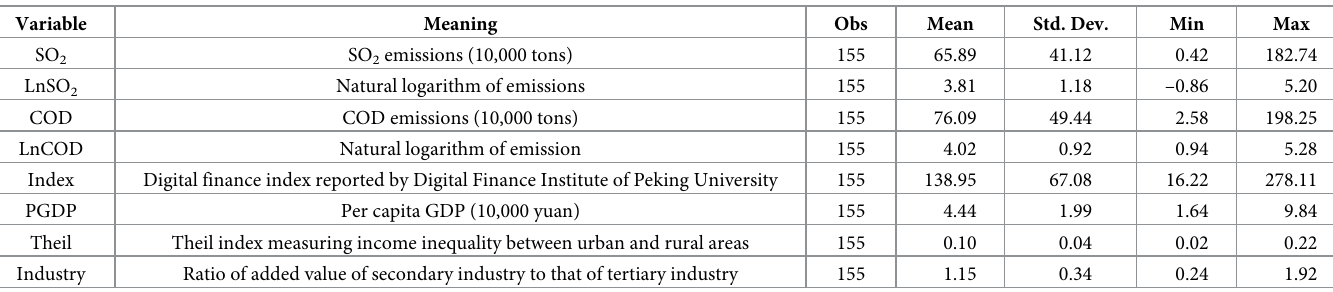
Table 1. Descriptions of variables and